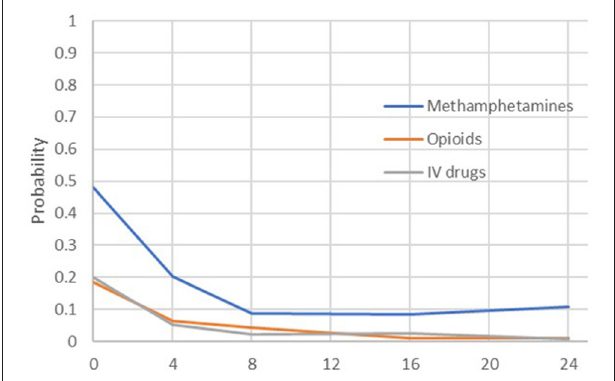
FIGURE 3 | Predicted probabilities of opioid or methamphetamine use by parents across the assessment period.